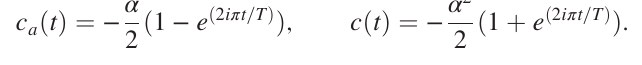
further to two-photon driven dissipations modeled by